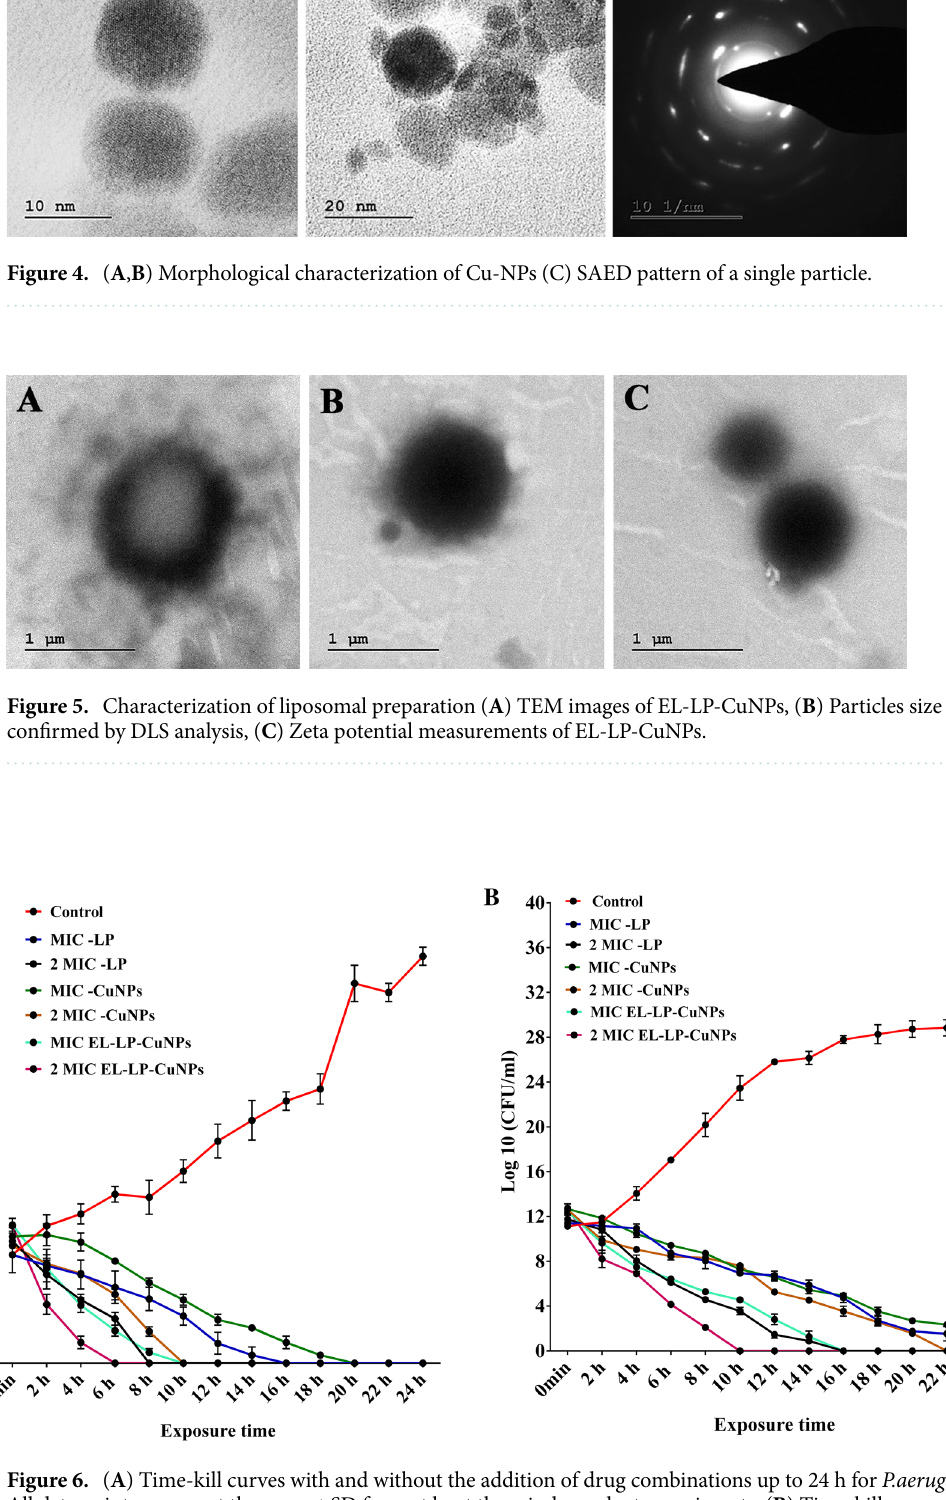
Figure 6. ( A ) Time-kill curves with and without the addition of drug combinations up to 24 h for P.aeruginosa. All data points represent the mean ± SD from at least three independent experiments. ( B ) Time-kill curves with and without the addition of drug combinations up to 24 h for MRSA. All data points represent the mean ± SD from at least three independent